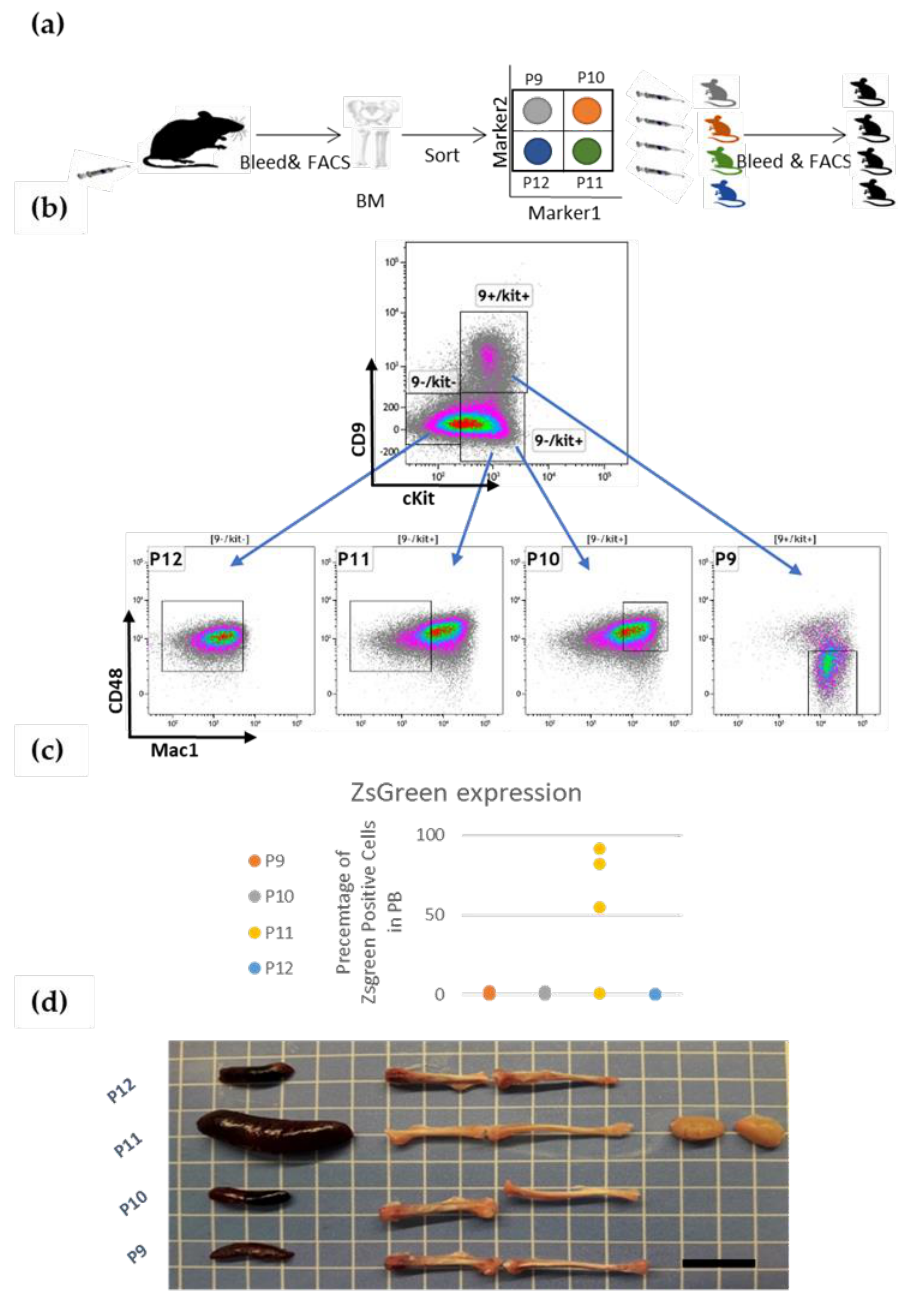
Figure 2. Prospective isolation of LSCs in ML23 ( a ) schematic illustration of experimental design. Fresh Leukemic cells were sorted into four sub-populations, and each sub-population was trans- ferred into a new host and its effects were examined. Gating for ML23 sub-populations using cKit/CD9 and CD48/Mac1. ( b ) FACS plots of leukemic cells, pre-gated ZsGreen+, as sorted into defined sub-populations. ( c ) ZsGreen+ expression levels from each transplanted sub-population. P11 sub-population transplanted mice presented high ZsGreen+ expression; others did not. ( d ) Or- gans from animals that received the indicated sub-population of ML23. Enlarged spleen, white bones, and enlarged LN are shown from P11. Representative data are shown from one out of three independent